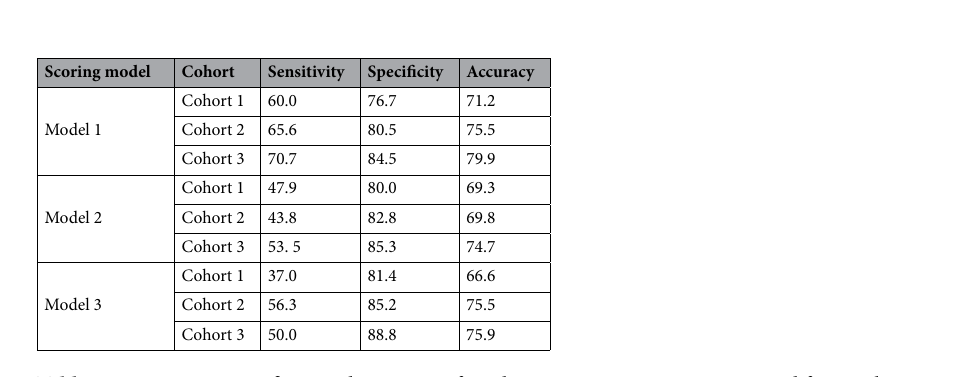
Table 6. Sensitivity, specificity and accuracy of predictive SNP score system assessed from cohort